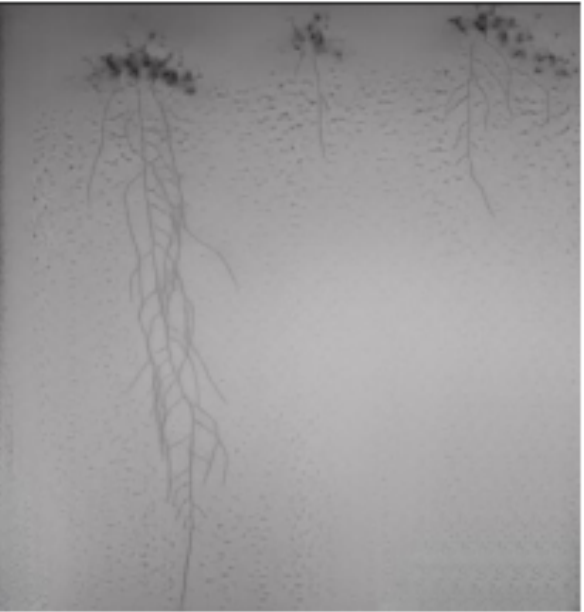
Figure 7. Example of a generated image from our trained cGAN. The roots are clearly visible and look similar to our original dataset. The Arabidopsis thaliana leaves are not translated in the generated images since semantic label maps were not created for